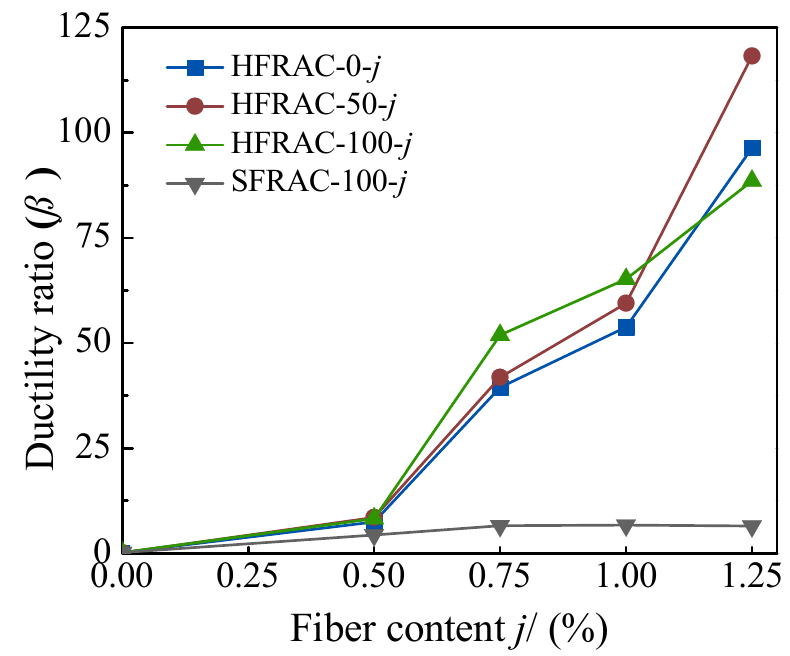
Figure 4. Ductility ratio of HFRAC/SFRAC.